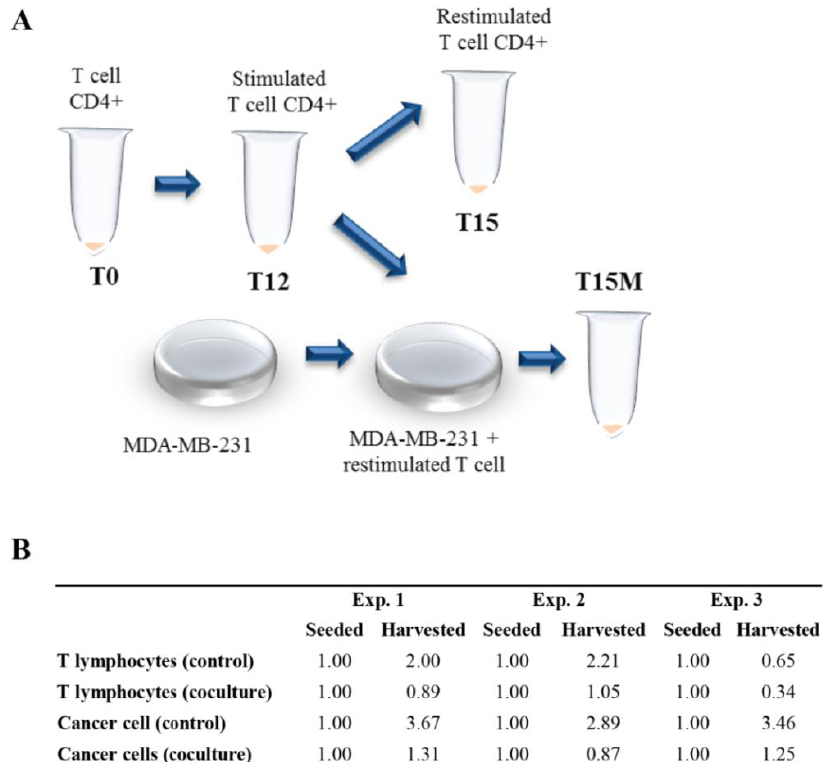
Figure 1. CD4 + T cells and MDA-MB-231 cancer cell growth is mutually inhibited in mixed cell cultures: ( A ) the schematic diagram of the experiment leading to the exhaustion of permanently activated CD4 + T cells, which is accelerated by MDA-MB-231 breast cancer cells; ( B ) data table showing 3 independent experiments performed with CD4 + T cells co-cultured with MDA-MB-231 breast cancer cells vs. CD4 + T cells cultured in the absence of cancer cells. The numbers of calculated cells are given in mln.